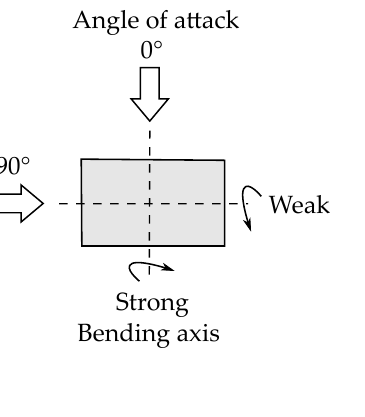
Figure 6. Definition of the wind loading: direction and simulation